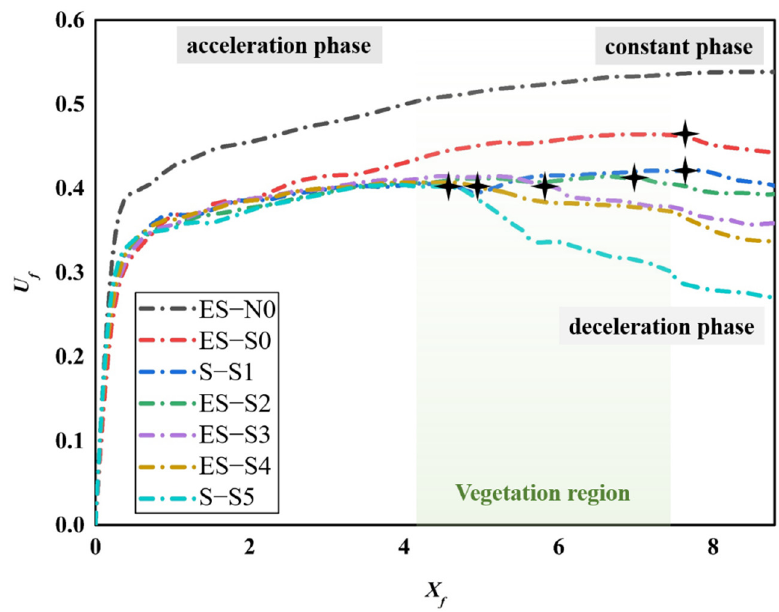
Figure 7. Spatial evolution of the dimensionless front velocity of gravity current. The light green rectangle marks the vegetation region, and the black asterisk indicates the transition point between the acceleration and deceleration phases.